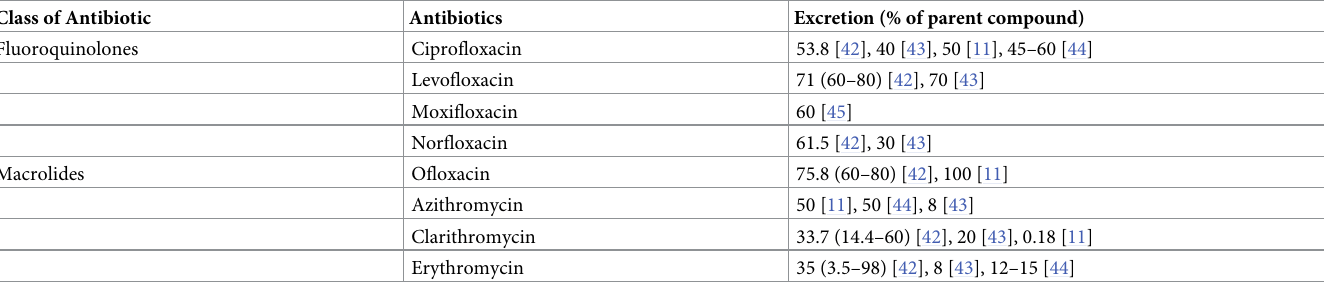
Table 4. Human excretion of fluoroquinolones and macrolides as a percentage of the parent compound.